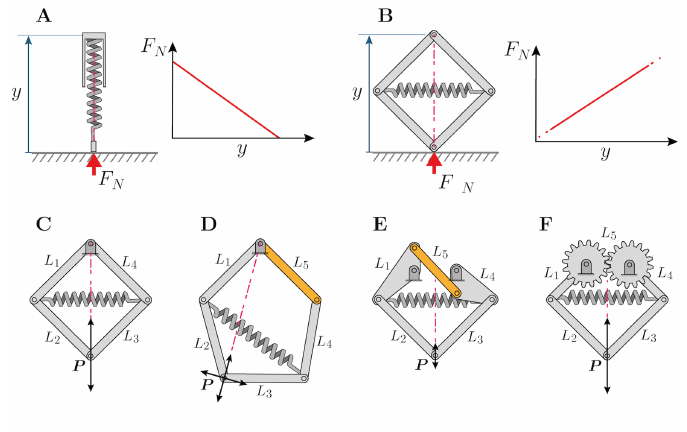
Figure 1. The telescopic prismatic mechanism ( A ) and hinge rhomb linkage ( B ), with their char- acteristic ground reaction force with longitudinal displacement graph. From ( C – F ), synthesis of a synchronous hinge rhomb linkage using a pair of synchronising gears. Dotted line extremes in graph B highlight singular or nonlinear behaviour of F N with y for specific geometry configurations; these aspects will be discussed in subsequent